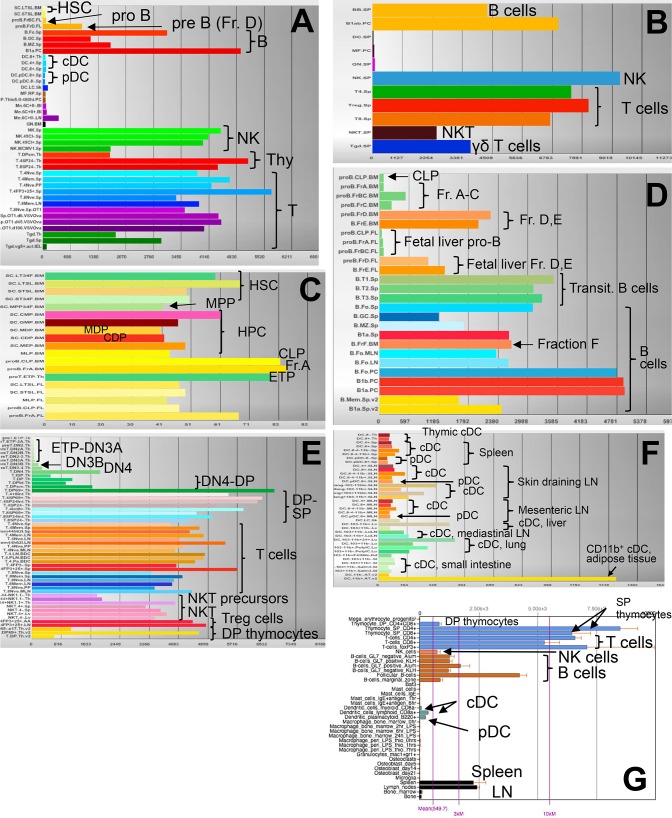

Murine CD2 mRNA tissue expression profiles.Shown are ImmGen Consortium [53] (www.immgen.org) probe set 10500677 (A-F) and BioGPS [54,55] (www.biogps.org) probe set 1418770_at (G)
murine CD2 mRNA expression profiles across (A, B) key hematopoietic cell populations, (C) HSC and HPC populations, (D) B cell developmental and mature populations, (E) T cell and NKT cell developmental and mature populations, (F) DC subsets and (G) multiple hematopoietic tissues and cell types. In (G), non-hematopoietic tissues are not shown because they did not express CD2. HSC, hematopoietic stem cells; HPC, hematopoietic progenitor cells; MPP, multipotent progenitors; MDP, monocyte-DC precursors; CDP, common DC precursors; CLP, common lymphoid progenitors; Fr. A, fraction A pre-pro B cells; pro B, pro B cells; Fr. B,C, fraction B and C pro- and early pre B cells; pre B (D), fraction D late pre B cells; Fr. F, fraction F recirculating mature B cells [19,34]; NK, NK cells; Thy, thymocyte; ETP, early thymocyte progenitor; DN3A, DN3B, DN4, CD4-CD8- thymocyte subsets; DP, CD4+CD8+ thymocytes; SP, CD4+ and CD8+ thymocytes; Treg cells, regulatory T cells; transit. B, transitional B cells.